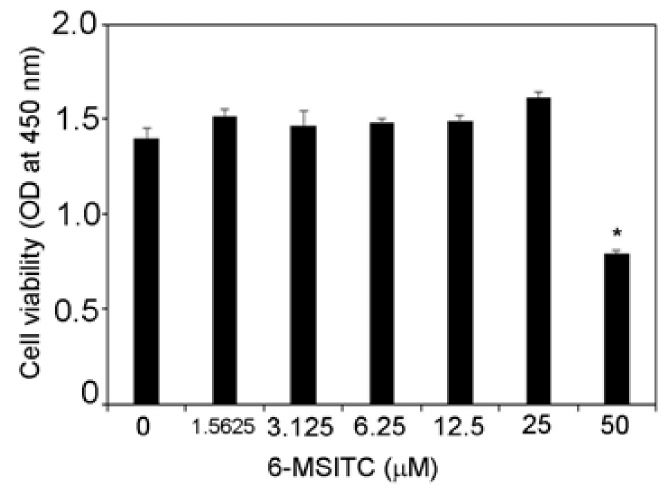
Figure 1. Effects of 6-MSITC on viability of TR146 cells. TR146 cells were seeded on 96-well cell culture plates, cultured for 2 days, and then treated with 6-MSITC (1.5625–50 µ M) for 24 h. Cell viability was assessed using Cell Count Reagent SF. Data are expressed as the mean ± SD of 4 independent experiments. * = p < 0.05, significantly different from the TR146 cells without